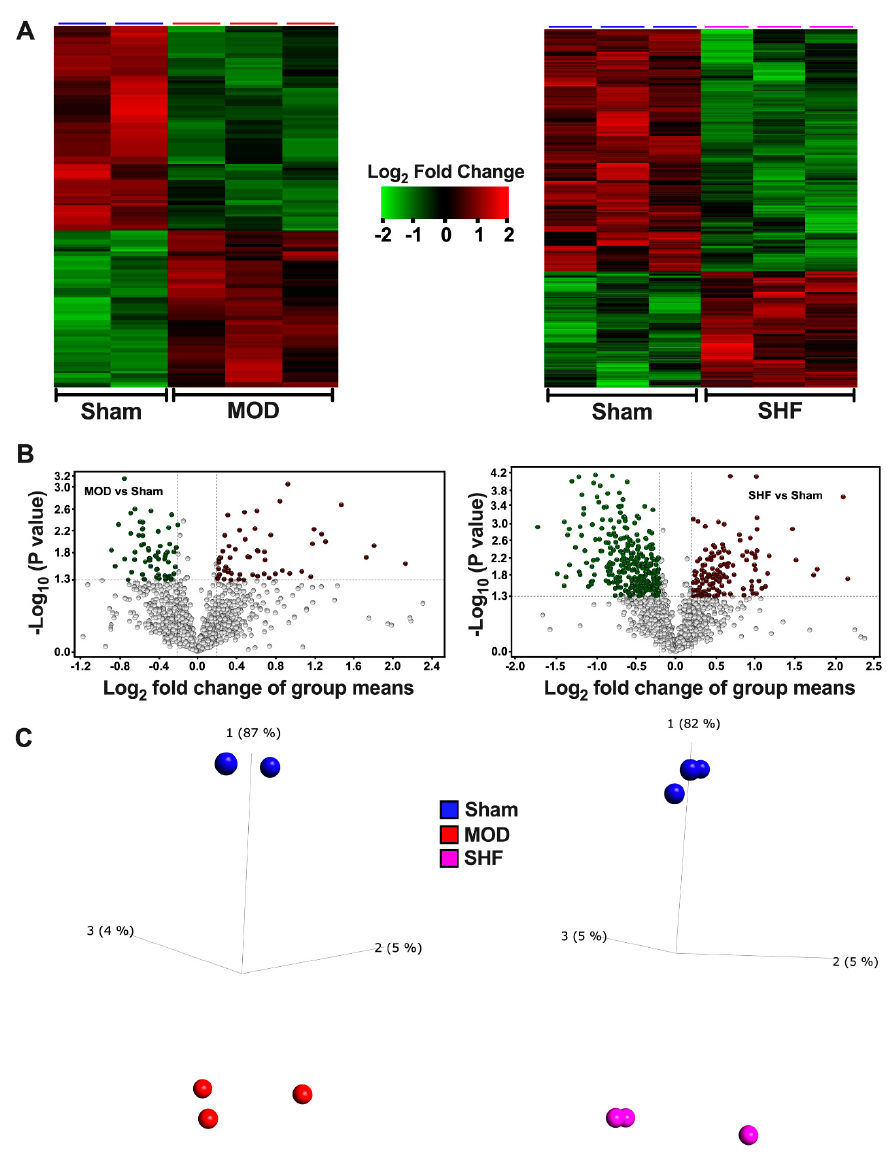
Figure 6. Visualization of the MOD and SHF phospho (p)-proteomic datasets. ( A ) Heat maps showing differential log 2 fold change in the expression of p-sites that changed in MOD vs. Sham (left), and in SHF vs. Sham (right). The same biological samples in the Sham group were used as a reference for both TMT-label p-proteomic runs; n = 3 biological samples per group. Note: there was a technical problem in one of the Sham biological samples in the MOD p-proteomic run, which was eliminated as it was skewing the data. ( B ) Volcano plots showing the degree of log 2 fold change, on the x -axis, with the corresponding -Log 10 p -value, on the y -axis, for the p-sites that were downreg- ulated (green) or upregulated (red) in MOD (left) and SHF (right) groups compared with Sham. ( C ) PCA plots showing the variance of biological samples in the Sham, MOD and SHF groups for the p-sites that changed in MOD (left) and SHF (right) vs. Sham.